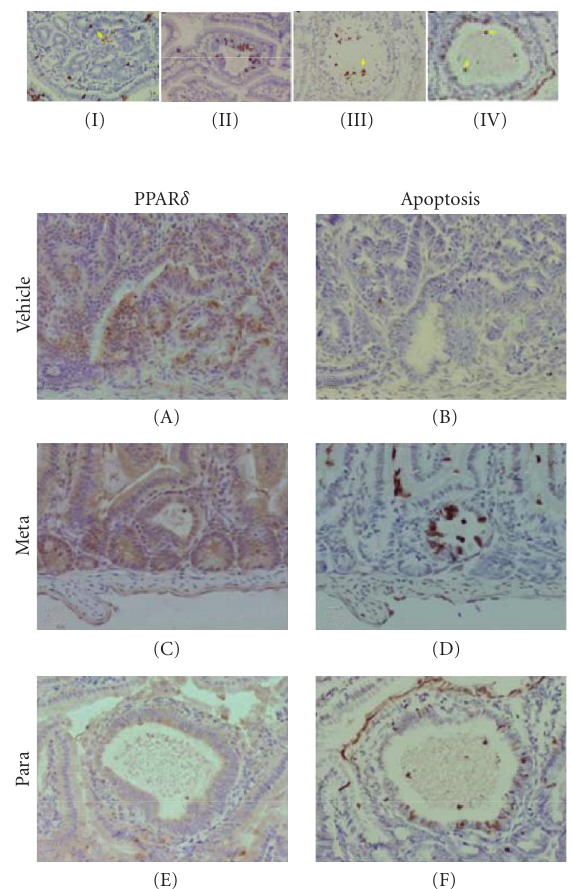
Figure 2: E ff ect of NO-ASA on PPAR δ and apoptosis in colon tissue of Min mice. Upper panel: the evolution of necrotic areas in intestinal tumors treated with p -NO-ASA; sections are stained by the TUNEL method. (I) Coalescence of TUNEL positive cells (arrow), representing the earliest stage; (II) abundant apoptotic cells at the margins of the developing area with contrast to their rarity in the surrounding area; (III) and (IV) the necrotic area is increasing in size, but TUNEL positive cells persist at its margins; TUNEL positive areas within the necrotic areas (arrows) suggest their cellular origin. Lower panel : the relationship of PPAR δ and apoptosis in NO-ASA treated intestinal tumors. Successive sections of intestinal tumors were stained for PPAR δ expression and apoptosis. The untreated tumor shows strong PPAR δ expression (A) and rare apoptotic cells (B). After treatment with meta or para NO-ASA, tumors show decreased PPAR δ expression (C) and (E) and increased apoptosis (D) and (F). Magnification is x400, adapted from Ouyang et al.